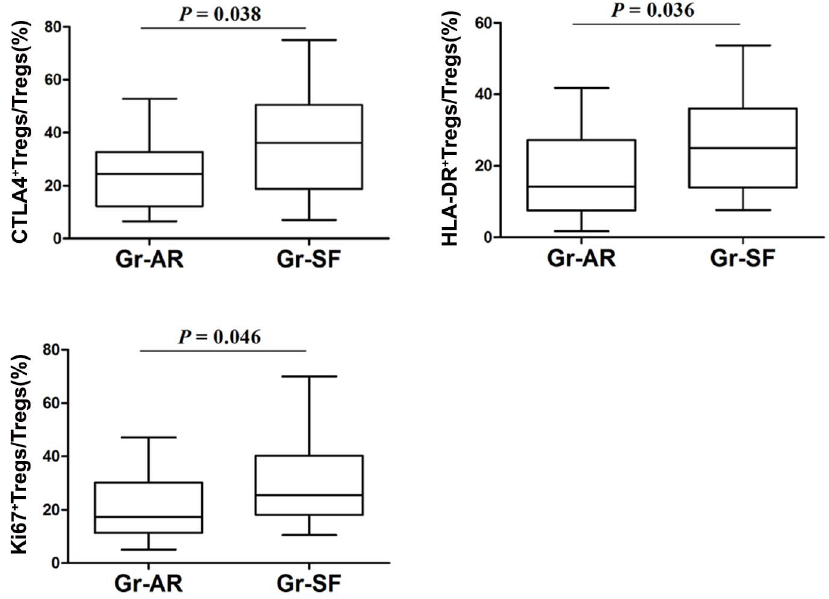
Figure 4. The phenotypes of CTLA-4 + , HLA-DR + , Ki67 + Tregs in liver transplant patients. The activated and proliferative molecules on Tregs were detected in liver transplant patients. The results showed that the frequencies of CTLA-4 + , HLA-DR + , and Ki67 + Tregs were higher in Gr-SF than in Gr-AR (all P , 0.05). The above data suggested more Tregs were active and proliferating in Gr-SF than in Gr-AR in liver transplant recipients.